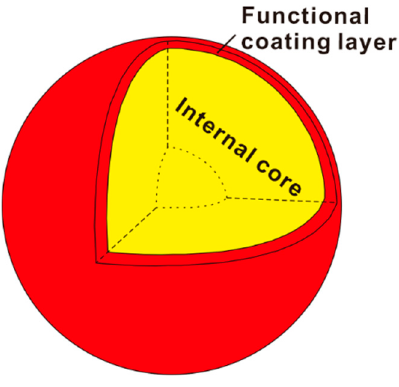
Figure 1. Schematic of MCL structure: the rigid internal core and the functional coating layer.